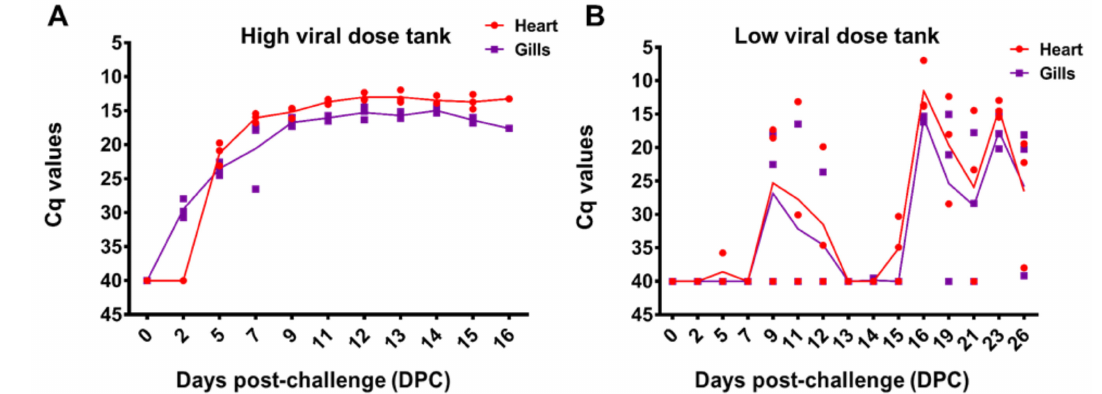
Figure 4. Infectious salmon anemia virus infection levels in the gills and heart tissues sampled at different time points (DPC) in HDg and LDg ISAV exposed individuals ( A ). The concentration of ISAV RNA per fish were analyzed by RT-PCR and presented as quantification cycle (Cq) values per days post-challenge ( B ). The dots represent the observed data from individual fish, while the lines represent the mean of the fish at each sampling time